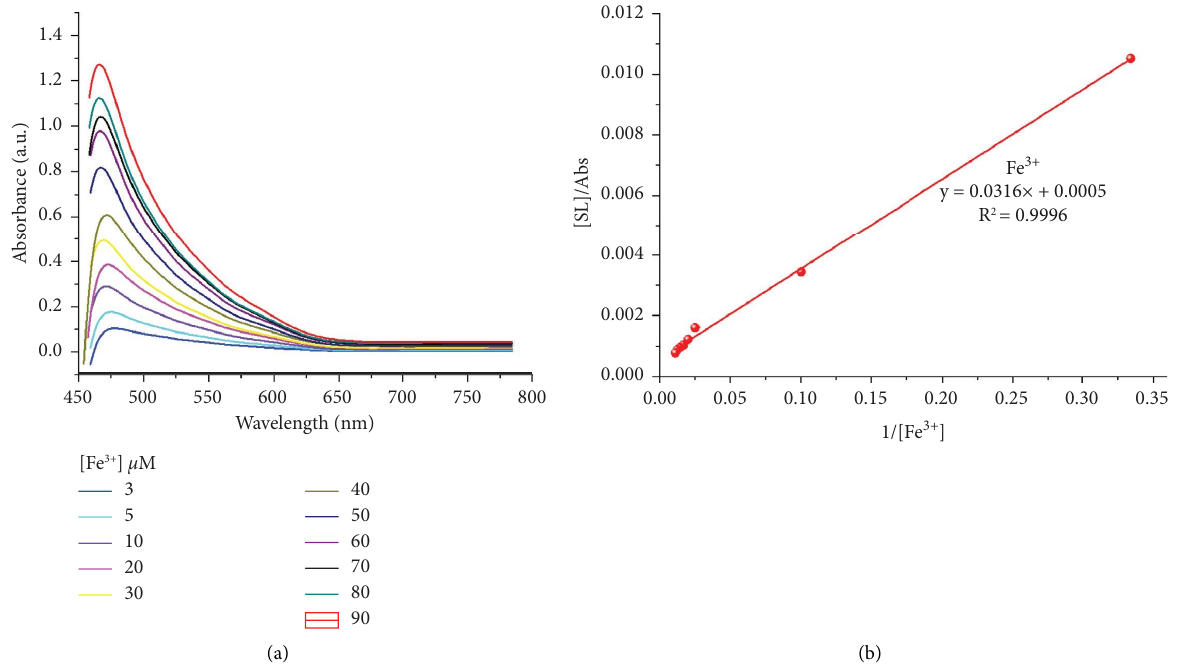
Figure 5: (a) UV–visible absorption spectra of SL upon the addition of diferent equiv. of Fe 3+ ions with absorbance intensity of SL as a function of Fe 3+ concentration at 470nm (inset), and (b) Benesi–Hildebrand plot of [SL]/Abs against 1/[Fe 3+